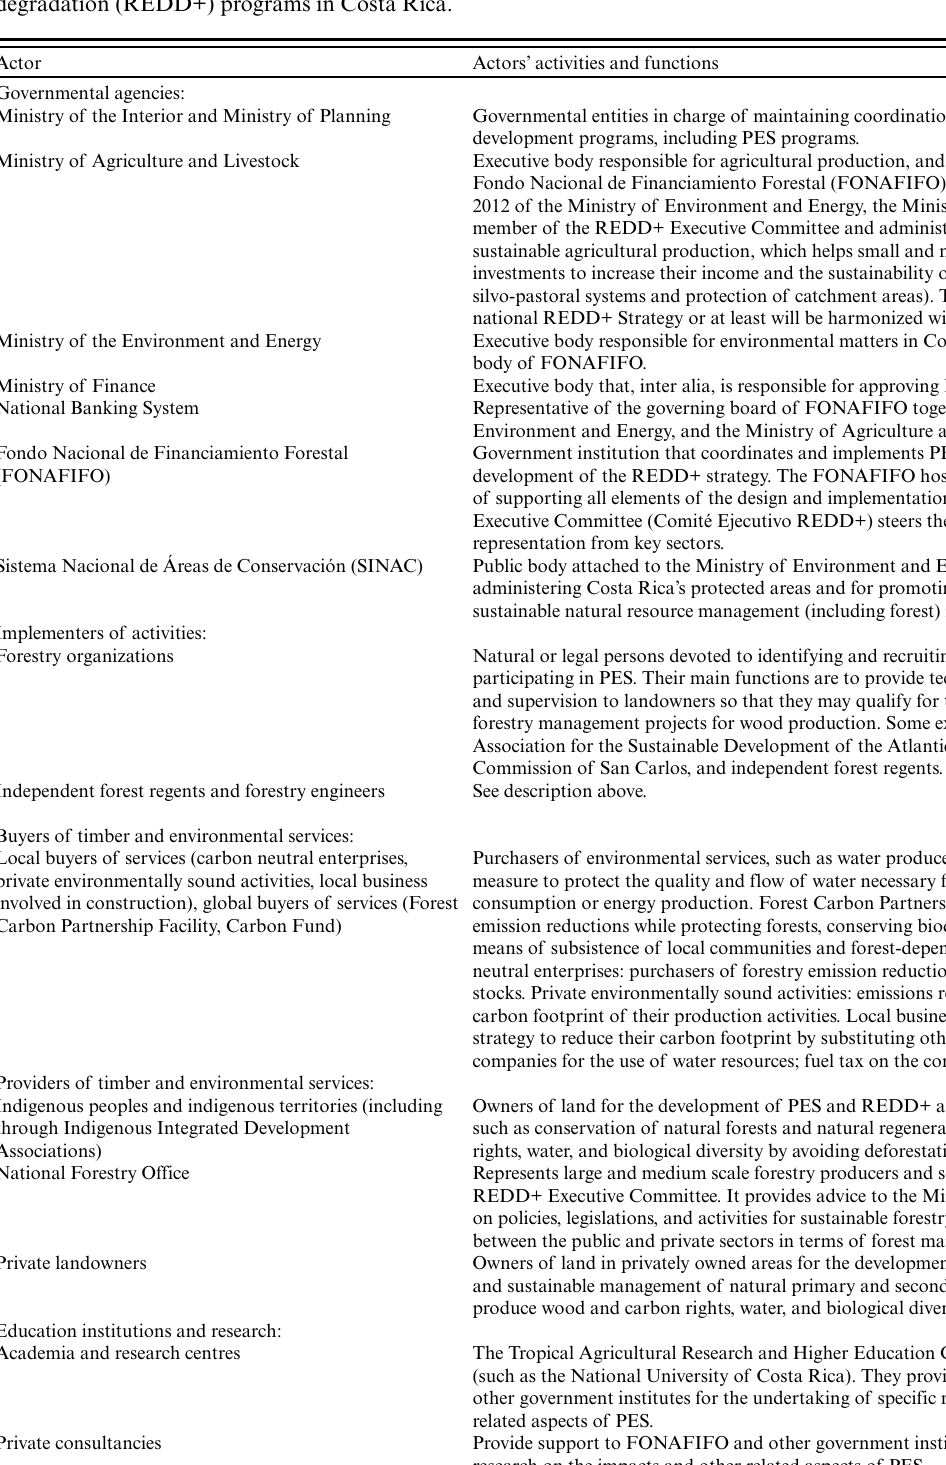
Table 1 . Major actors involved in payment for environmental services (PES) and reducing emissions from deforestation and forest degradation (REDD+) programs in Costa